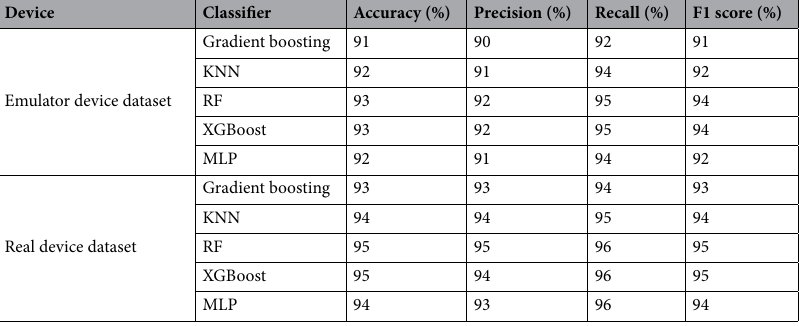
Table 6. Accuracy, precision, recall and F1 score.